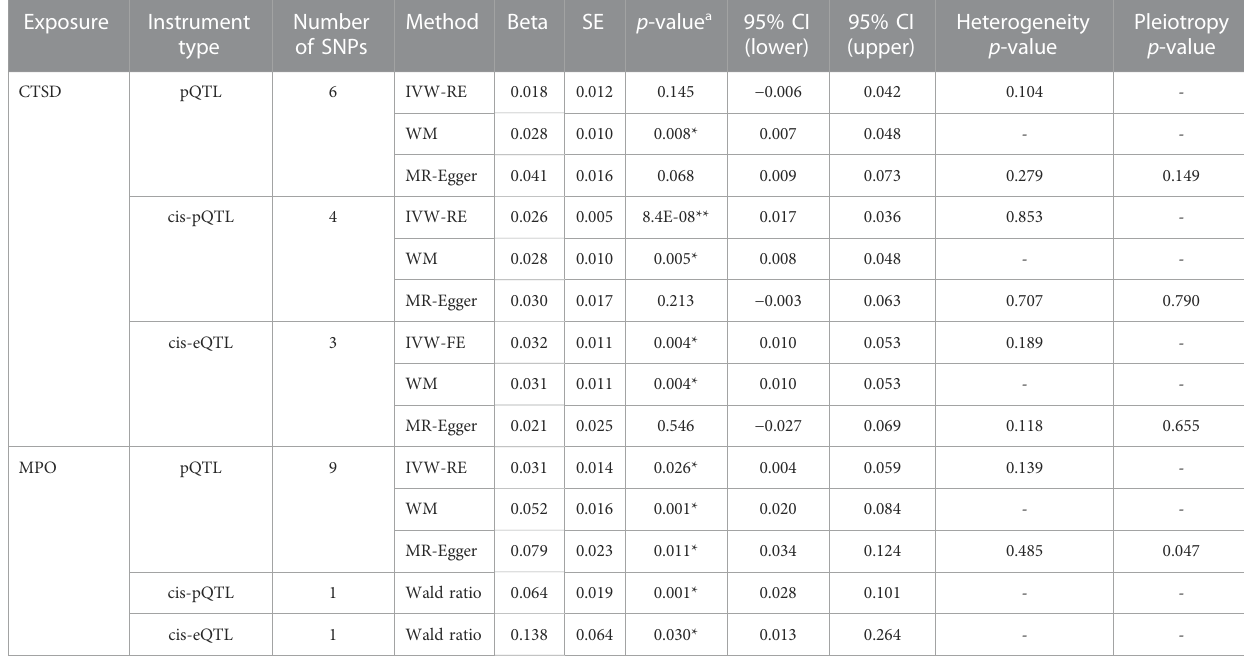
TABLE 1 ( Continued ) Associations of circulating proteins with cognitive performance based on Mendelian randomisation analyses.